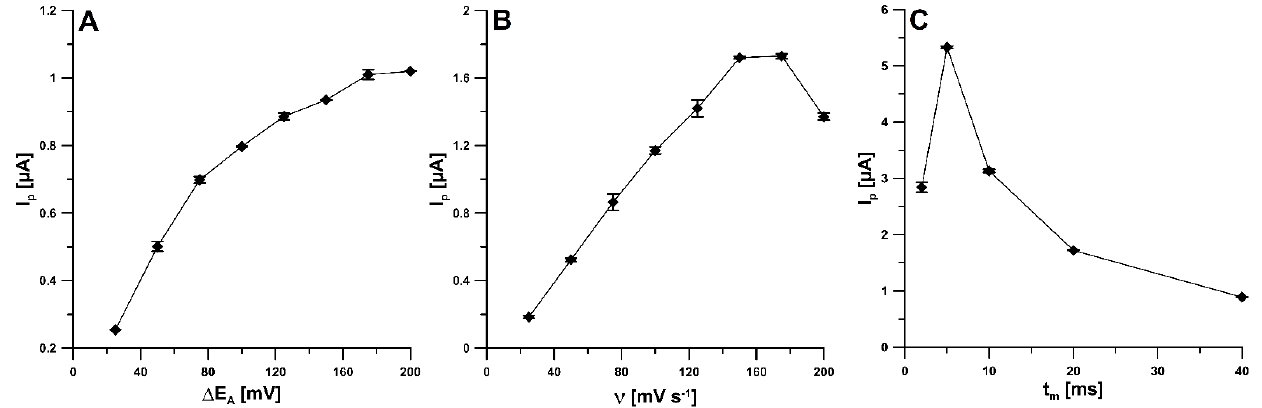
Figure 7. Influence of ( A ) Δ E A , ( B ) ν , and ( C ) t m on the analytical signal of 50 nM NDIT. The mean values of I p are given with the standard deviation for n =